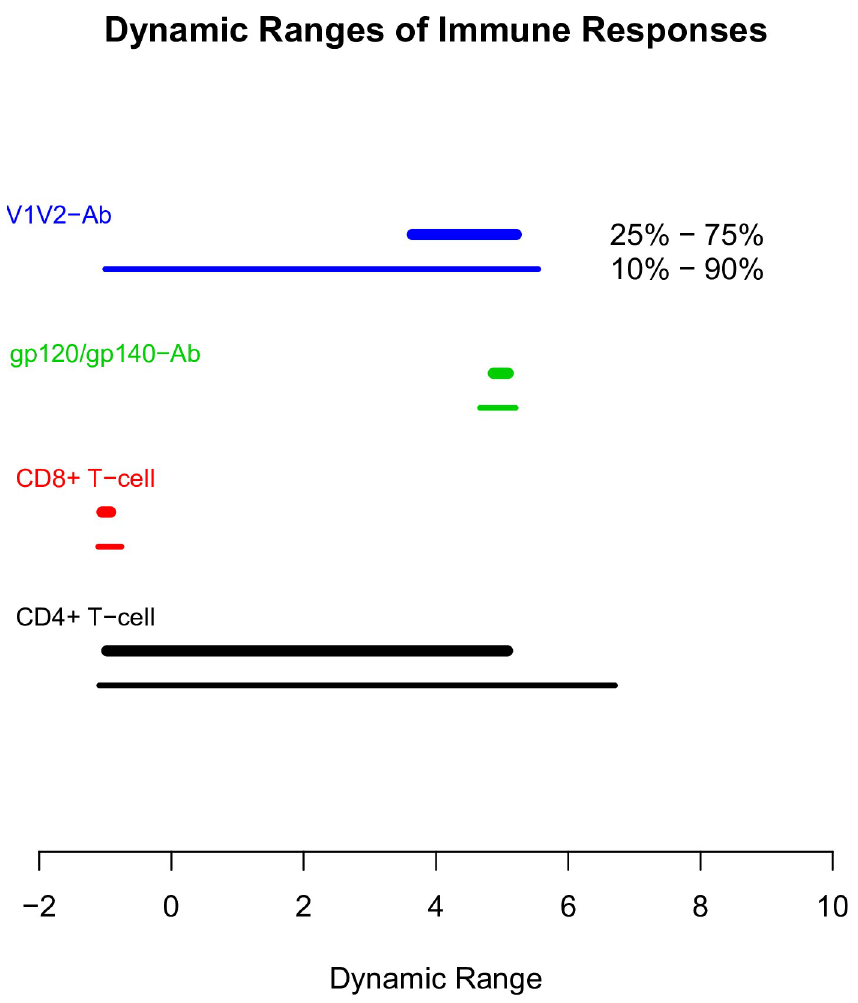
Fig 6. Dynamic ranges of the 64 immune responses shared across the three trials. The ranges of the immune responses after bi-directional power transformation are shown (25 th percentile to 75 th percentile, thicker lines; 10 th percentile to 90 th percentile, thinner lines). Lines are color-coded by response